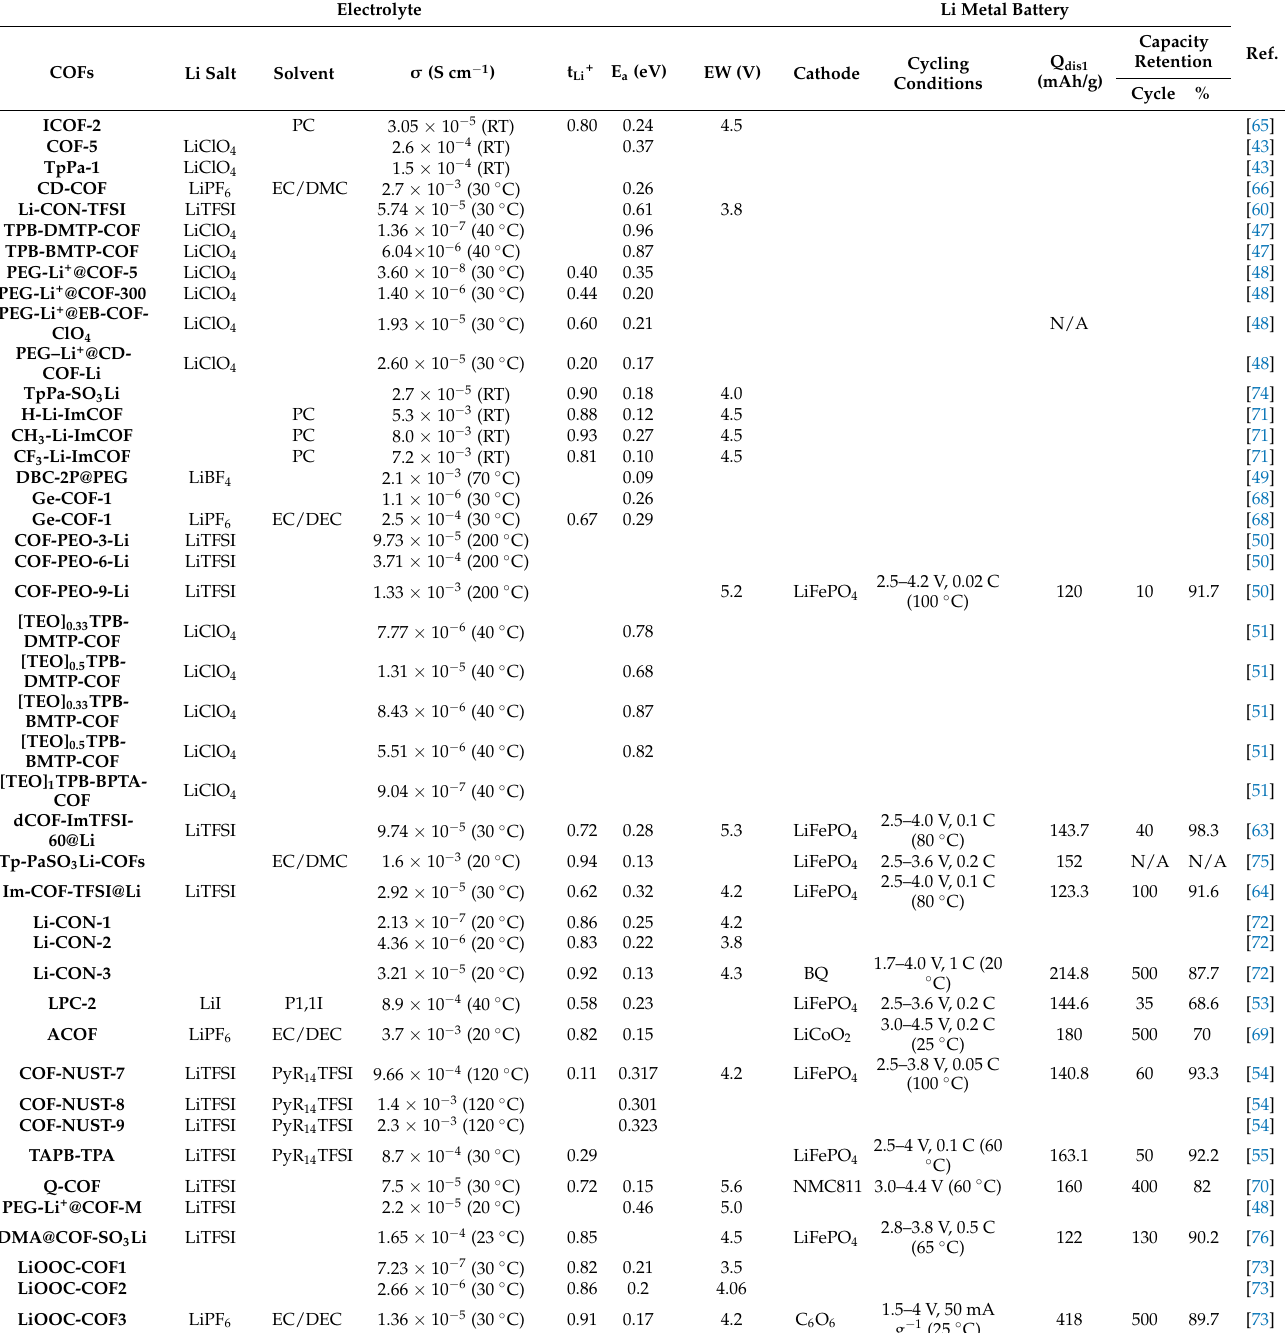
Table 1. Summary of the major performances of COF-based